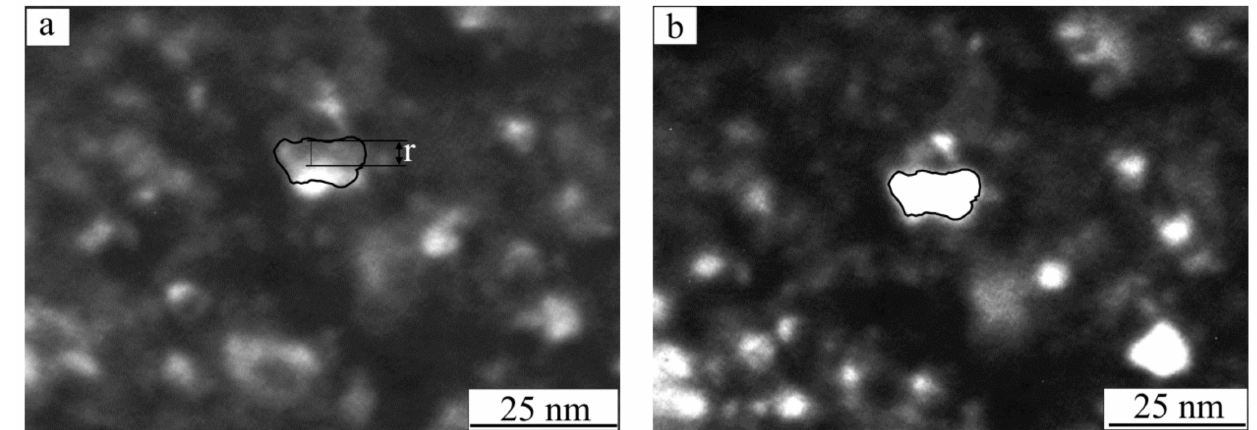
Figure 10. Dark-field images of extinction contour displacement in a nanocrystalline region under the indenter’s tip with foil inclination: ( a ) sample tilt angle 0 ◦ , ( b ) sample tilt angle 0.5 ◦ (see explanation in